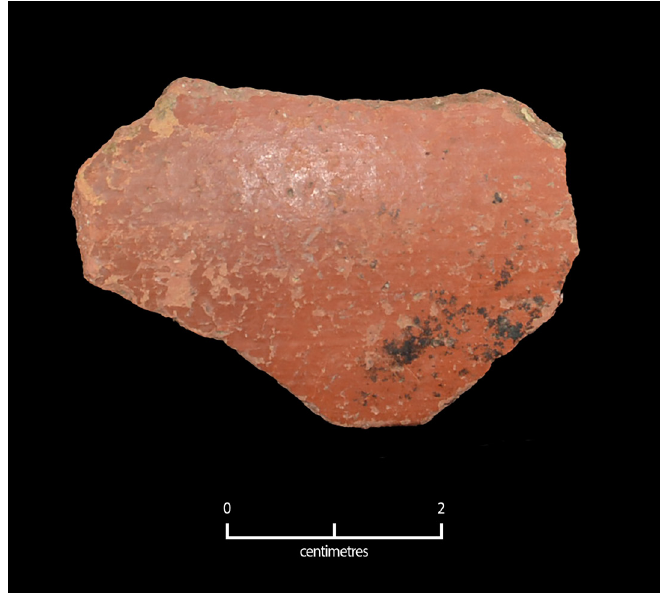
Figure 26: External surface of a Class 7 variant 3 potsherd, with burnished red